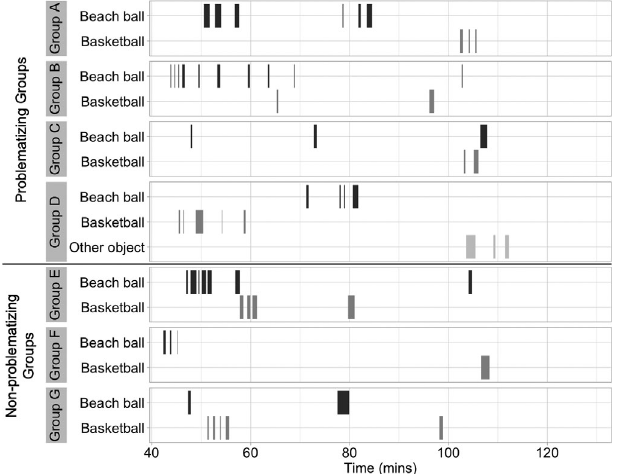
FIG. 7. Timing of data collection for all groups. For most groups, data collection occurs frequently. Group F experiences a large gap in time between their collection of data for the two balls. Group G does not obtain usable data during their first attempt with the beach ball, only obtaining beach ball data to analyze beginning at 75 min into the lab. Group D, which does problematize, was the only group to attempt to collect data using other objects to test their